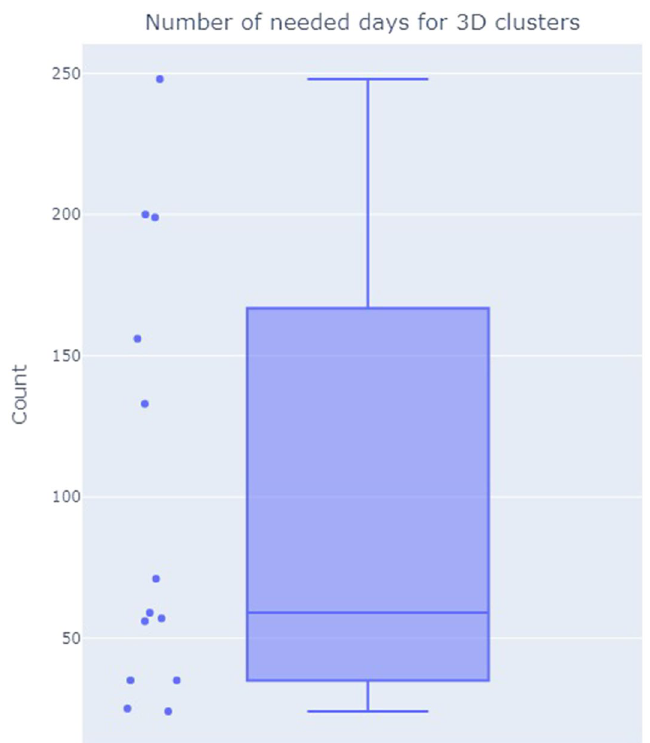
Fig. 9 Distribution of the convergence time in terms of the number of days in the 3-D clustering